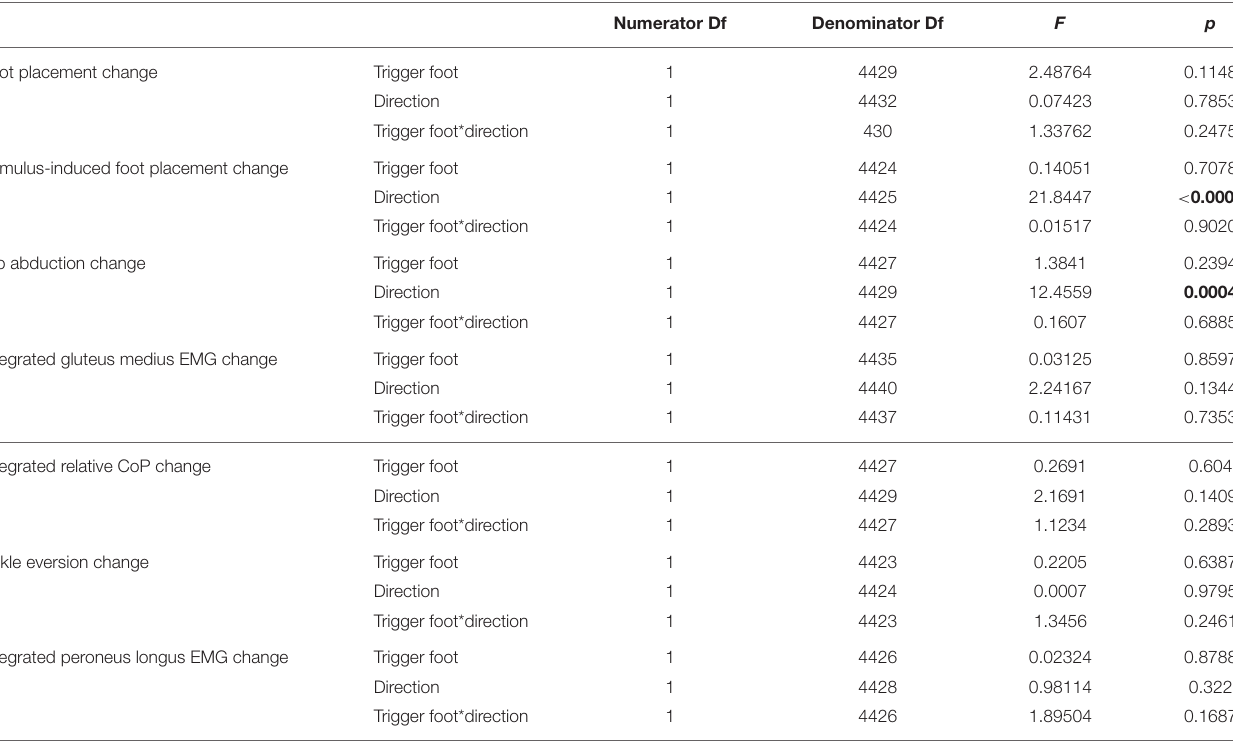
TABLE 2 | Results of the ANOVA indicating which factors have a significant effect on the magnitude of the motor response to the visual stimulus (see Table 3 for statistics on the existence of the motor responses).